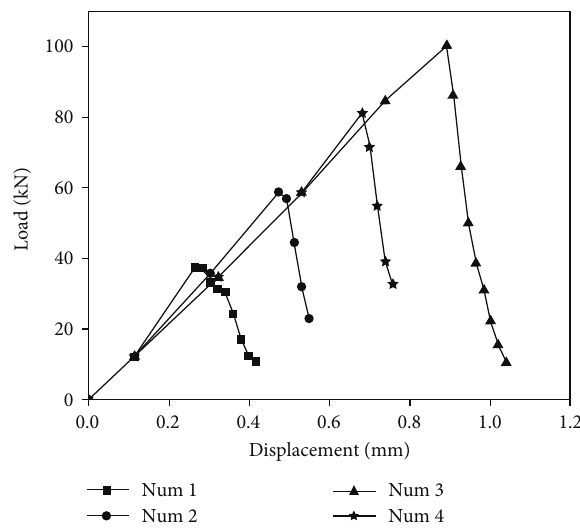
Figure 7: Load-displacement curves of di ff erent strength ratios under the same particle